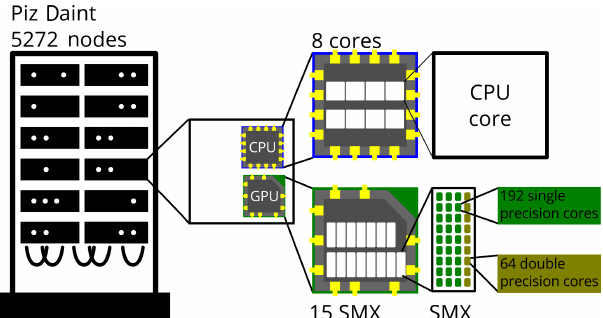
Figure 11. Heterogenous node architecture in Piz Daint. Each het- erogenous node contains an eight-core Intel Xeon E5-2670 CPU and an Nvidia K20X GPU with 15 Streaming Multiprocessors (SMX). Each SMX contains 192 single precision compute cores and 64 double precision compute